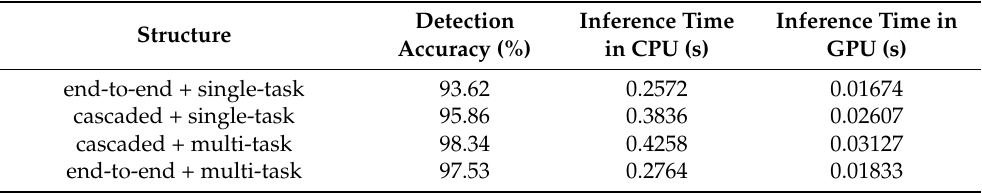
Table 5. Speed performance comparison for different model structures for the sorting network.